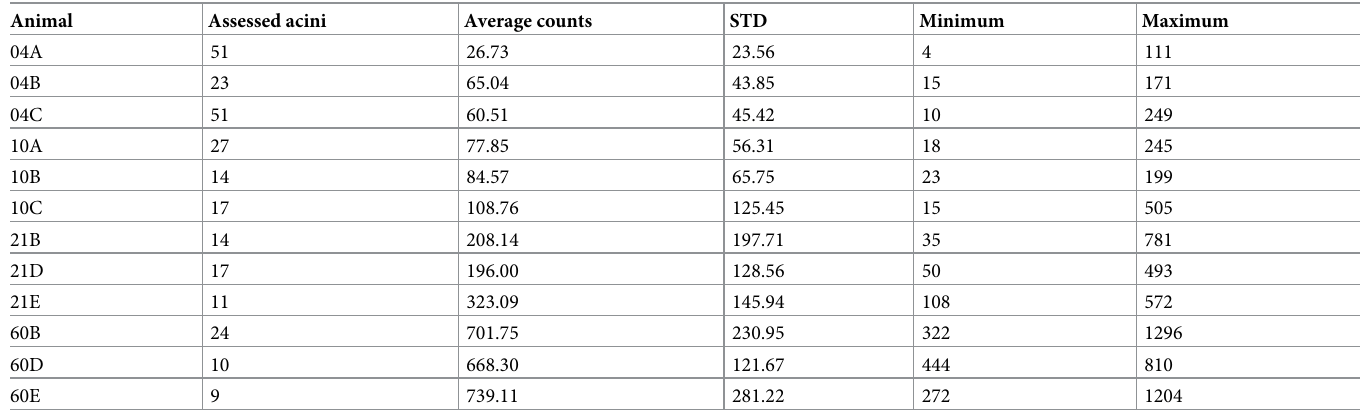
Table 1. Detailed alveolar numbers for each animal.